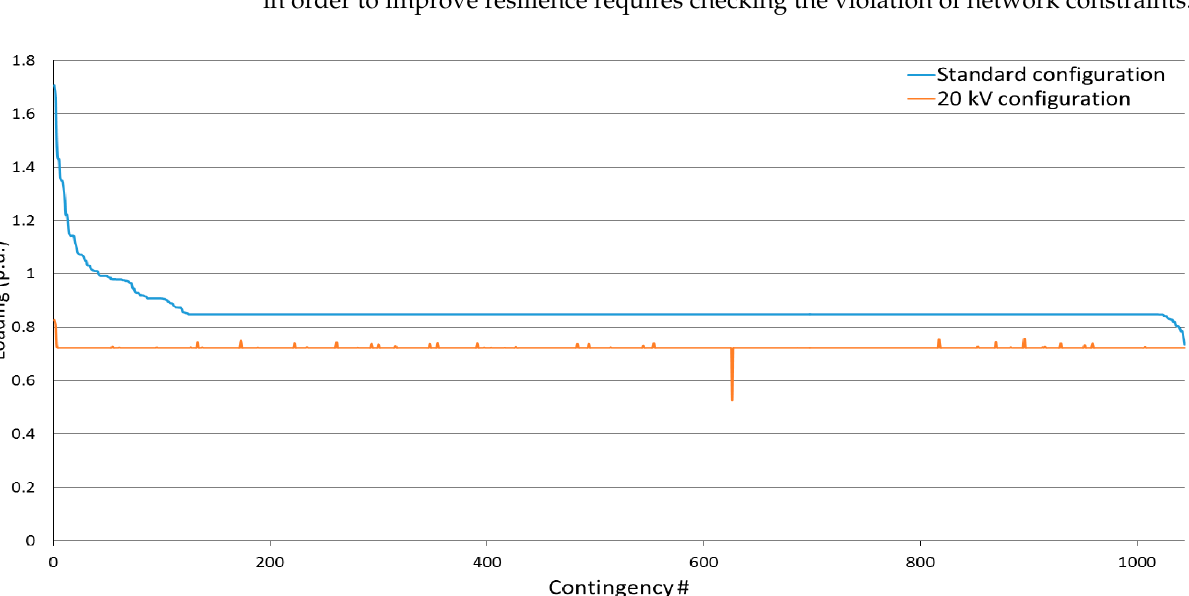
Figure 10. Maximum loadings (in p.u. of the branch capacity) due to contingencies involving branches in antenna.